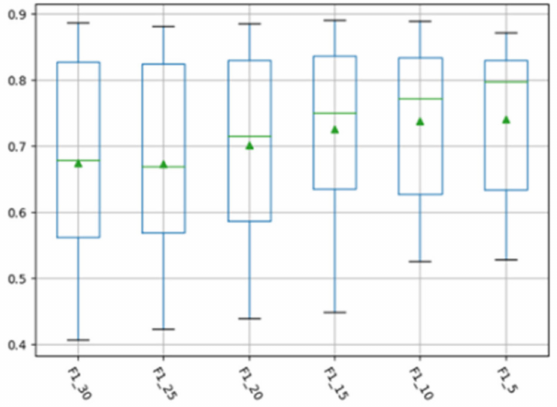
Figure 3. F1 values obtained from different subspace dimensions on the AEEEM